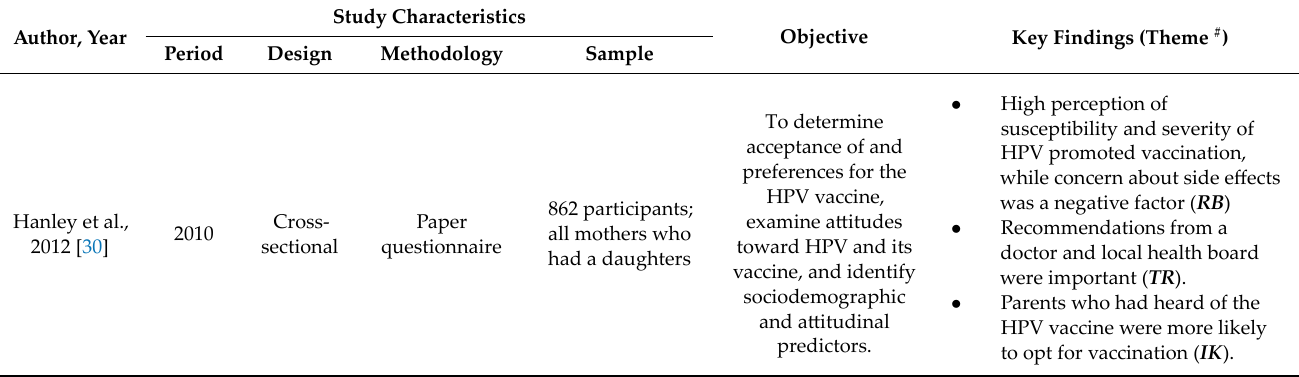
Table 2. Summary of included articles on human papillomavirus (HPV)